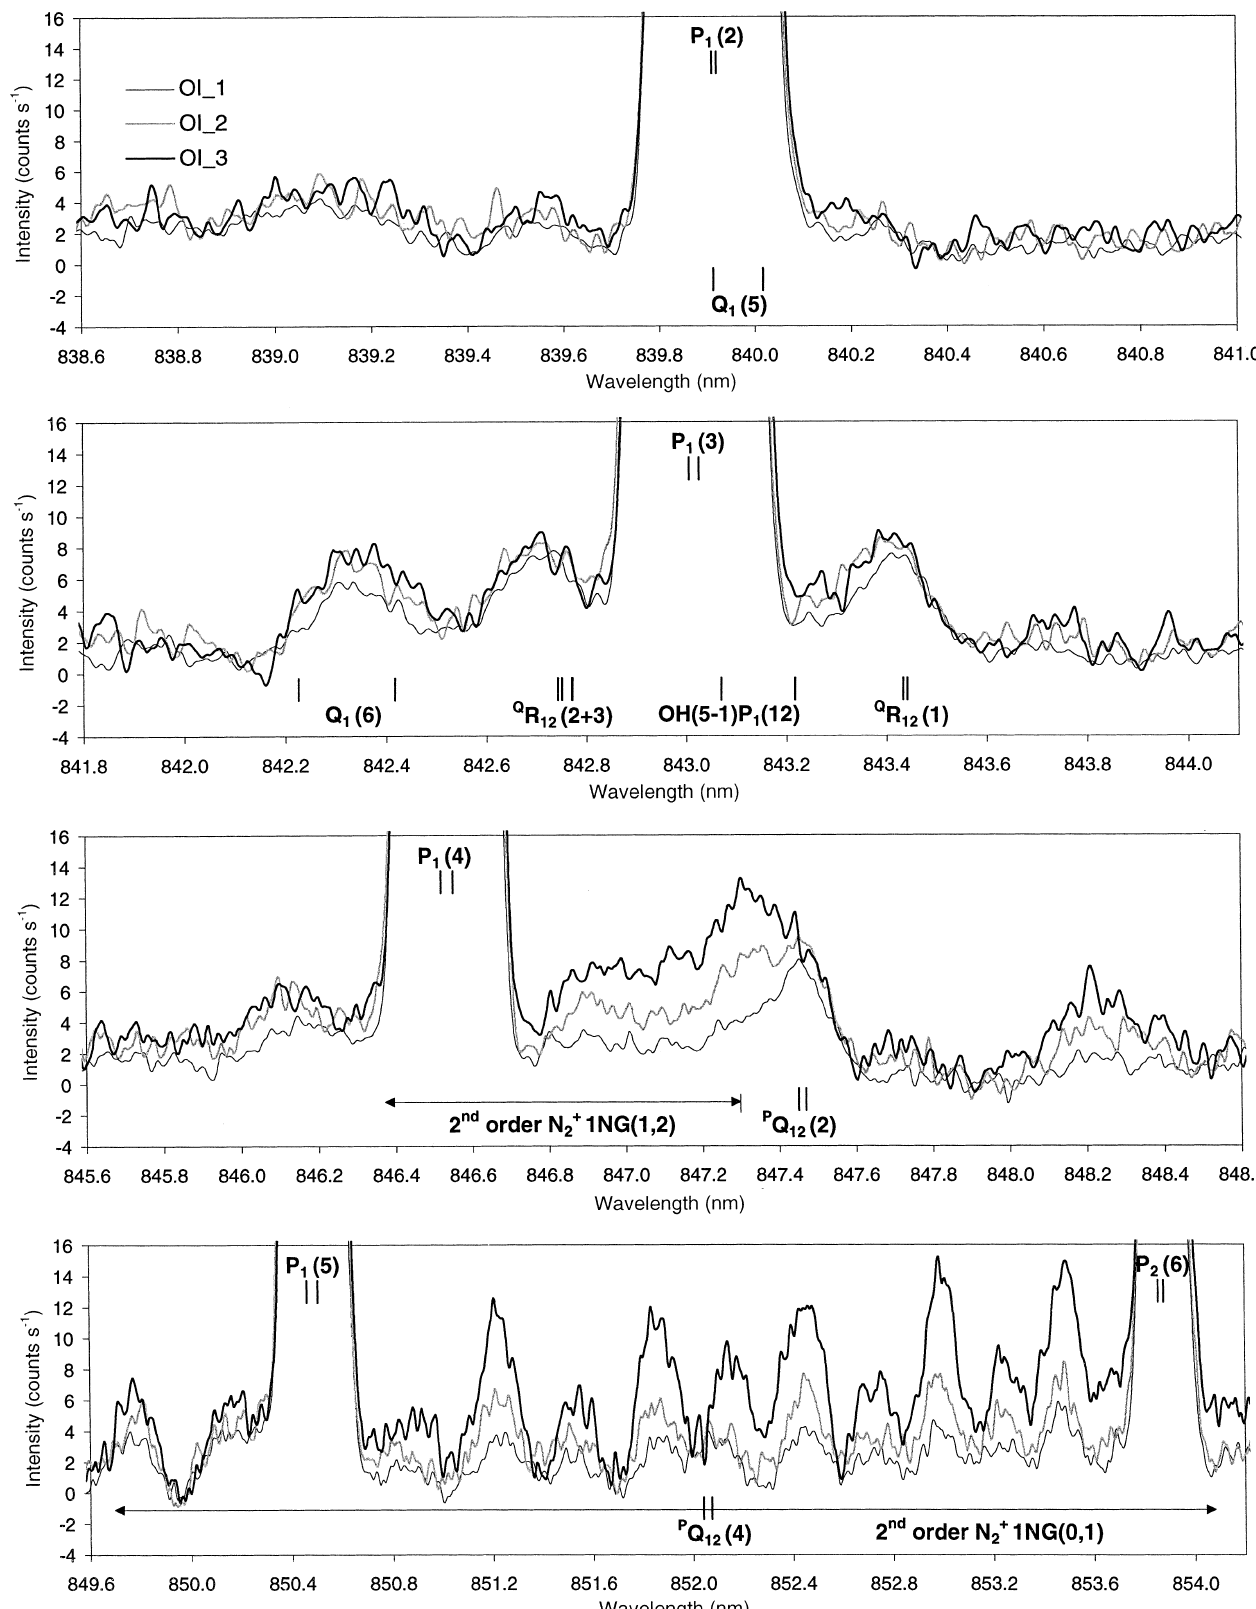
Fig. 2. Averaged and smoothed spectra, at three levels of auroral activity, showing the auroral dependence of weak spectral features in the vicinity of the P 1 (cid:133) 2 (cid:134) , P 1 (cid:133) 3 (cid:134) , P 1 (cid:133) 4 (cid:134) and P 1 (cid:133) 5 (cid:134) lines of the OH(6–2)